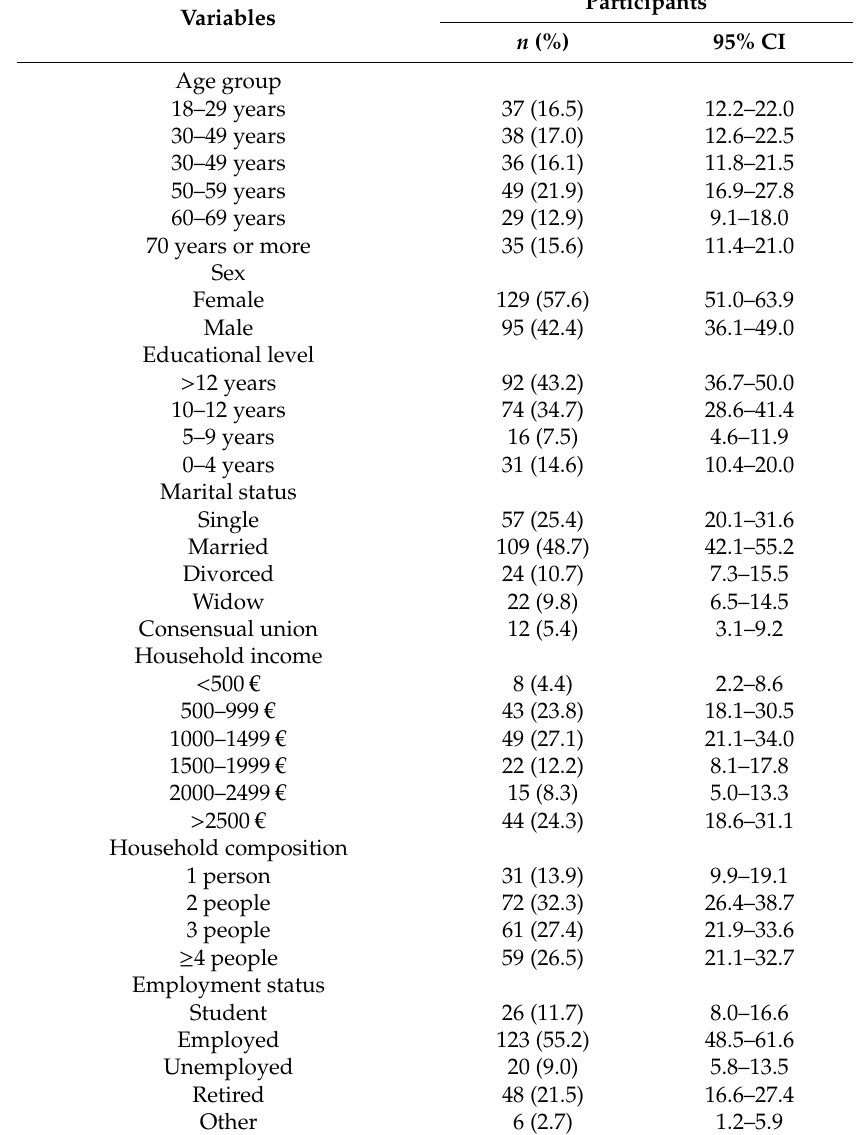
Table 2. Study participants’ socioeconomic